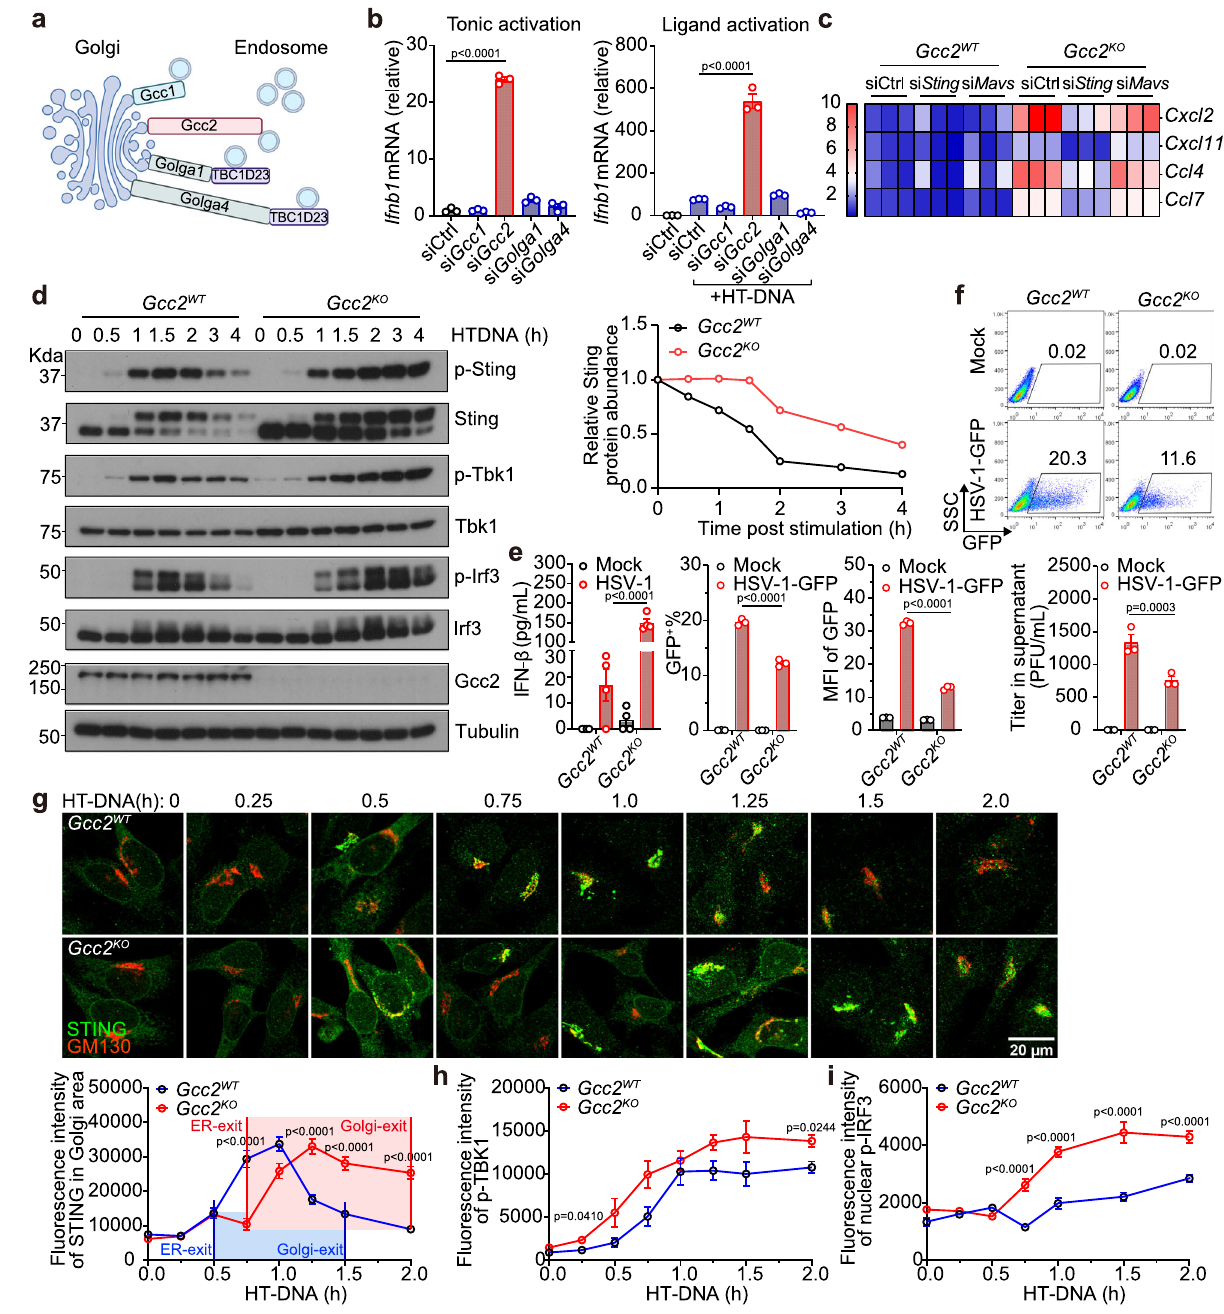
Fig. 2 | GCC2 is required for STING Golgi-exit. a A diagram of Golgin family members at the trans-Golgi network (TGN). b qRT-PCR analysis of tonic (left) or ligand-activated (right) lfnb1 mRNA expression after mock knockdown (siCtrl) or speci fi csiRNAknockdownof Gcc1 , Gcc2 , Golga1 ,or Golga4 inwild-typeMEFs. n =3. c A heatmap showing expression of indicated ISGs (right) at the resting-state in Gcc2 WT and Gcc2 KO MEFs after control, Sting , Mavs siRNA knockdown. d Western blot analysis of STING signaling kinetics. Gcc2 WT and Gcc2 KO MEFs were stimulated with HTDNA (1 µ g/mL) for indicated times (top). Quanti fi cation of relative Sting proteinabundance(normalizedtoTubulin,thenset0hvalueto1)areshownonthe right. p-Sting, p-Tbk1, and p-Irf3 are key phosphorylation events of the STING sig- naling pathway. e ELISAanalysisof mIFN- β inthe supernatant in Gcc2 WT and Gcc2 KO MEFs 24hafterHSV-GFPinfection(m.o.i.=1). n =4. f HSV-1-GFP infectionin Gcc2 WT and Gcc2 KO MEFs.Top,representativeFACSplotofGFPexpression24hafterHSV-1- GFP infection (m.o.i.=1). Lower panels, percentage of GFP + cells (lower left), GFP